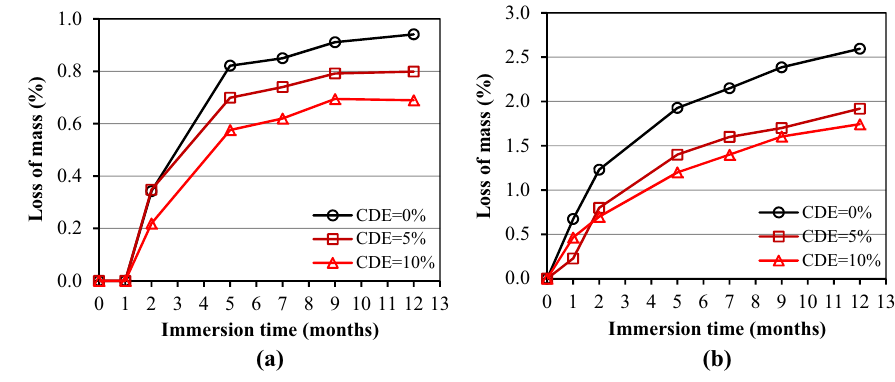
Figure 13: Loss of mass of UHPC after being immersed in: ( a ) NaCl and ( b ) Na 2 SO 4